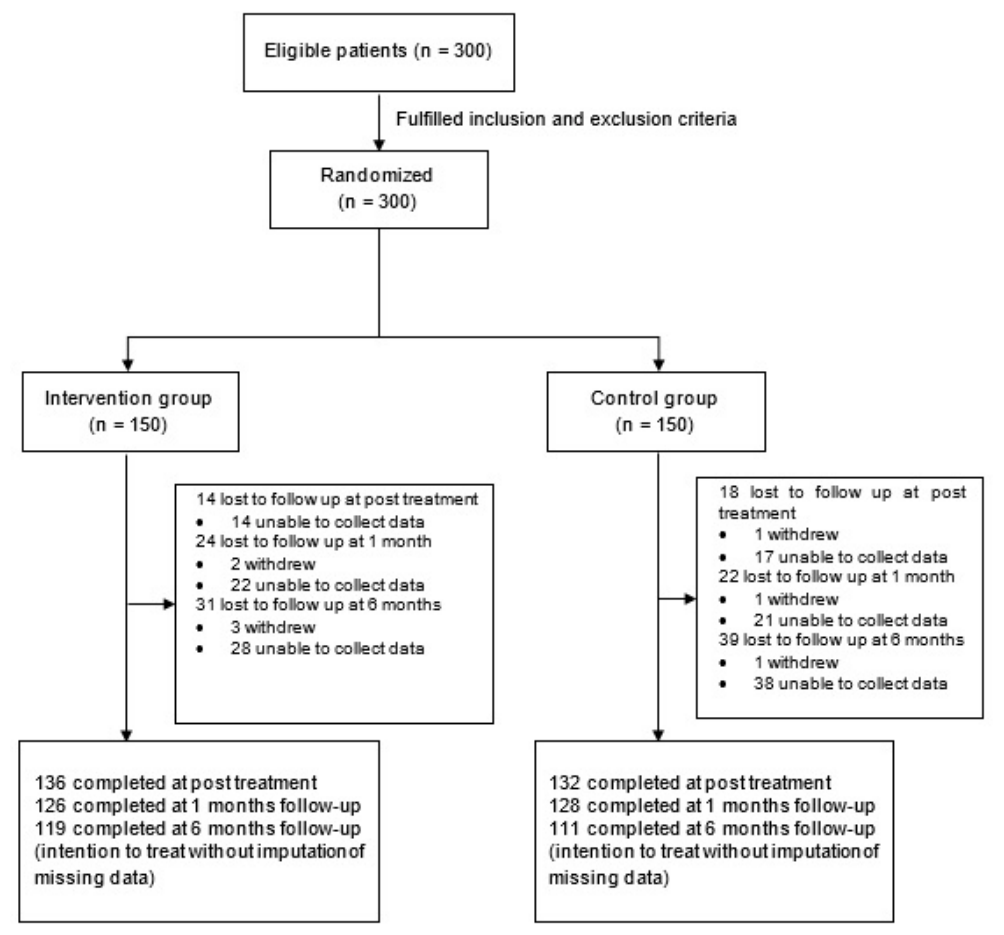
Figure 1. Consort flow chart of intervention and control groups.